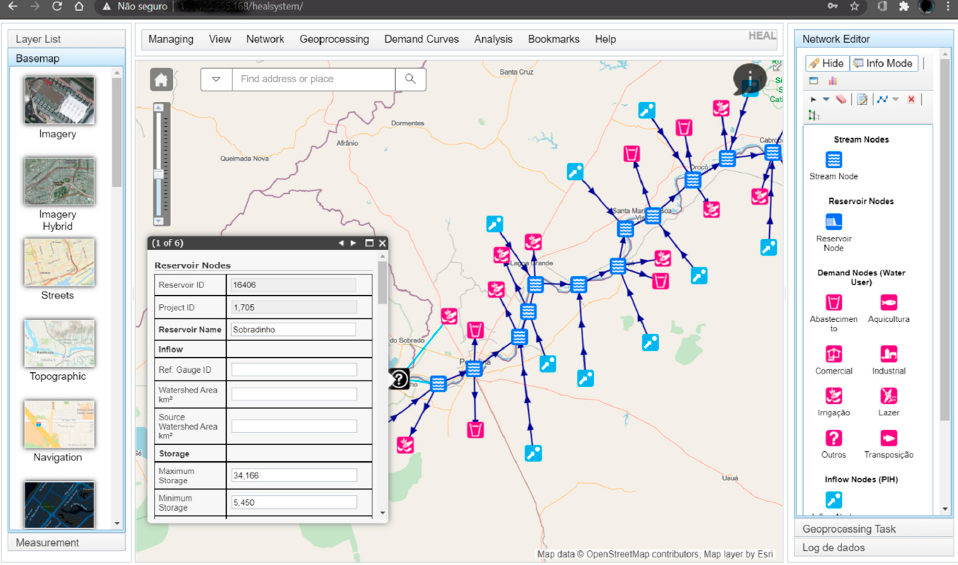
Figure 4. Interface HEAL system with node editor and attribute popup for reservoir node. The marginal benefit curves and the resulting benefit functions were obtained for irrigated agricultural production along the river (small farmers) and all municipalities in the Sub-Middle of the São Francisco river basin using scenarios [54]. Demand curves for public irrigation schemes (PIS) were obtained by using Positive Mathematical Programming (PMP). Concerning changes in soil use and climate change, MAgPIE global data [42] was used for the SRES projections [55] and the RCPs [56]. To obtain the marginal benefit curves for the future, regionalization and downscaling of regional and global data was used [57]. The São Francisco river transboundary project (PISF) is currently in the final phase. The point expansion method was used to obtain the demand curves for this water use [37,58,59], with estimates of the associated costs and benefits. For the reference (Baseline) and Climate Variability (CV) scenario, the minimum flow granted by ANA [60] was used as the upper water transfer limit. In scenario A2 (fragmentation), the maximum allowable capacity for the two axes and in scenario B1 the average flow of the two axes was used. The yearly marginal benefit curves for PISF were obtained using the same soil use patterns, crop mix and production values as in the donor basin, limiting the water to current and future demands, together with technical restrictions of the two channels. Regarding the transfer costs, the reference charges were considered for the provision of the PISF water transfer service [61], which resulted in relatively high charges of 0.204 R$/m³ for fixed cost and 0.303 R$/m³ for variable costs. Figure 5 shows the marginal benefit curves obtained for the two channels (axes) (Eixo Norte and Eixo Leste) in different scenarios. All curves are included in the code generated by HEAL system using polynomial regression coefficients of the obtained curves. Other data regarding the HEAL system and PISF is given in Appendix C.